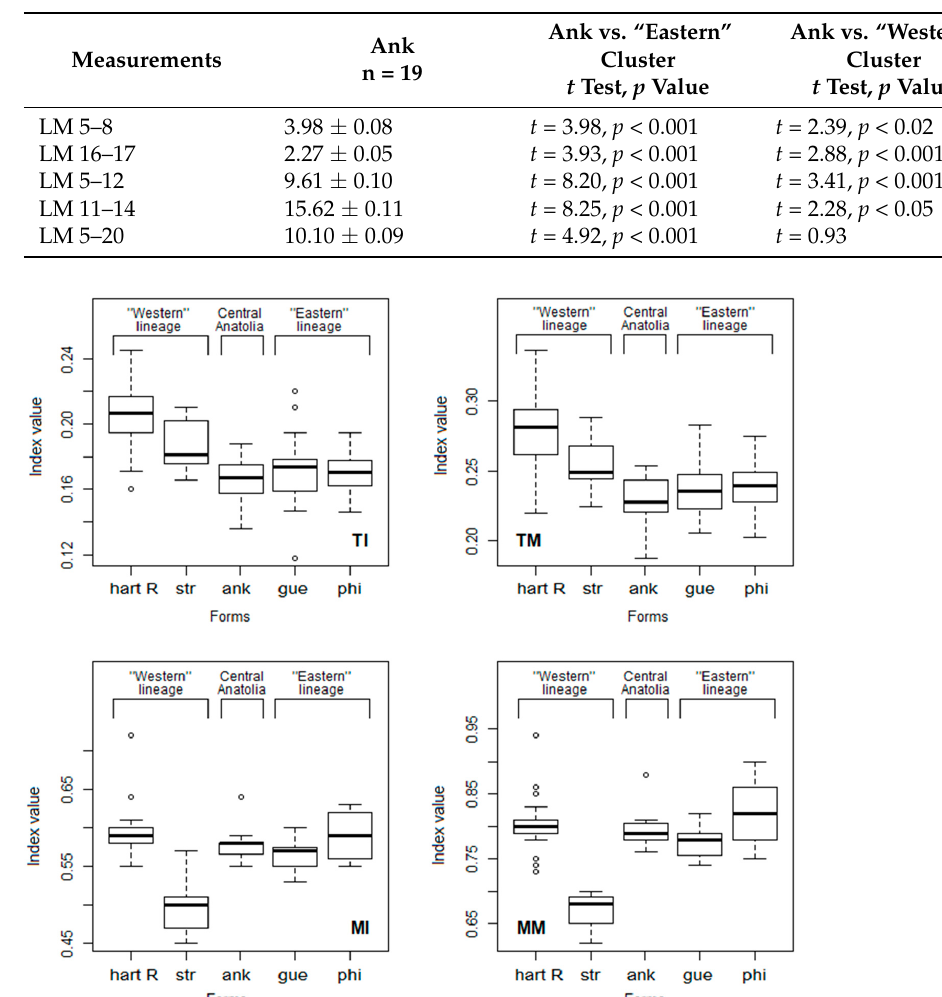
Table 4. A comparison of the linear size of the voles’ mandible between the eastern or western cluster of forms and M. h. ankaraensis .